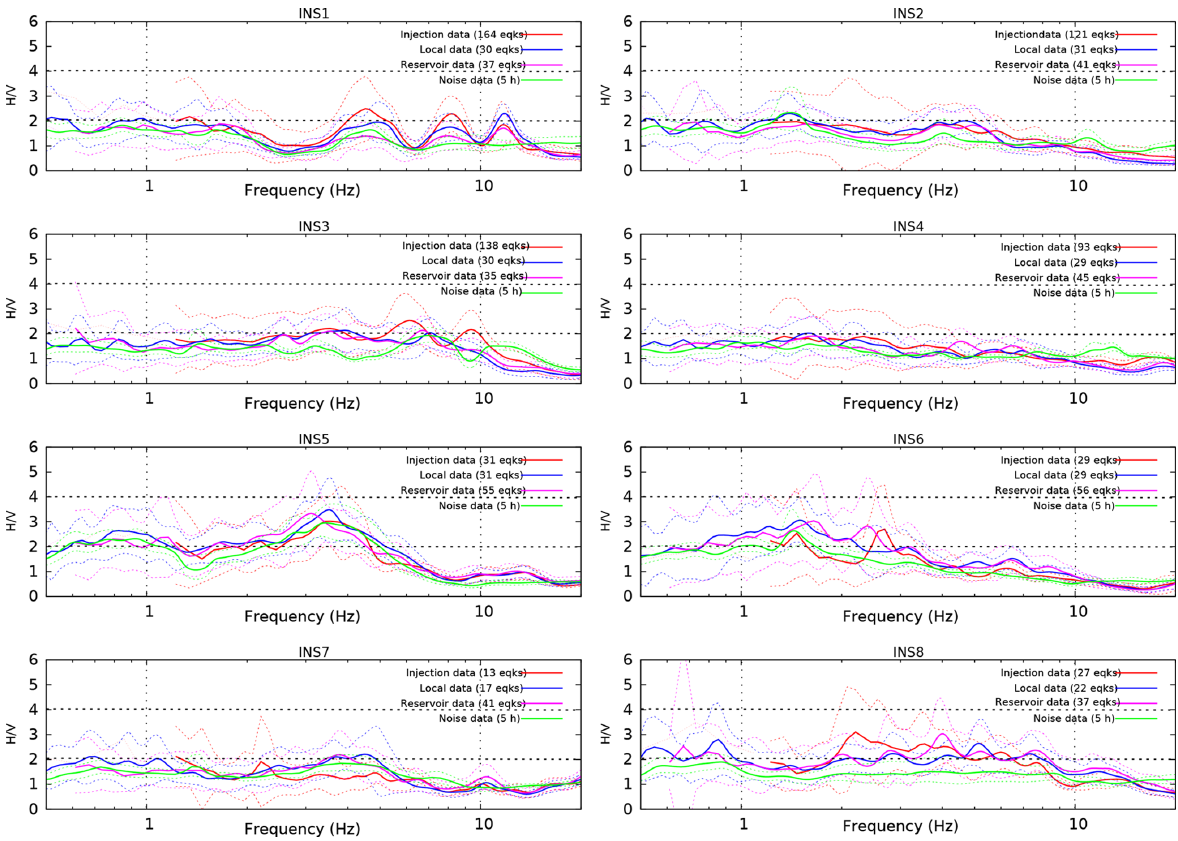
Figure 11. HVSR and HVNSR curves computed at all the INSIEME network seismic stations. For each dataset, the number of used earthquakes and the hours of seismic noise are indicated. The solid coloured lines represent the average HVSR and HVNSR curves, whereas the dashed lines identify the ± 1 σ standard